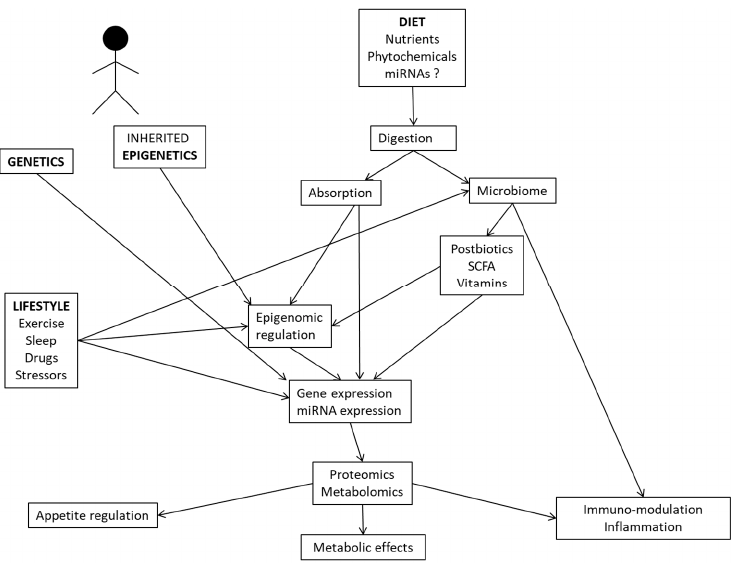
Figure 2. Interrelationships between multi-omics tools and environmental factors influencing human metabolism and physiological functions.